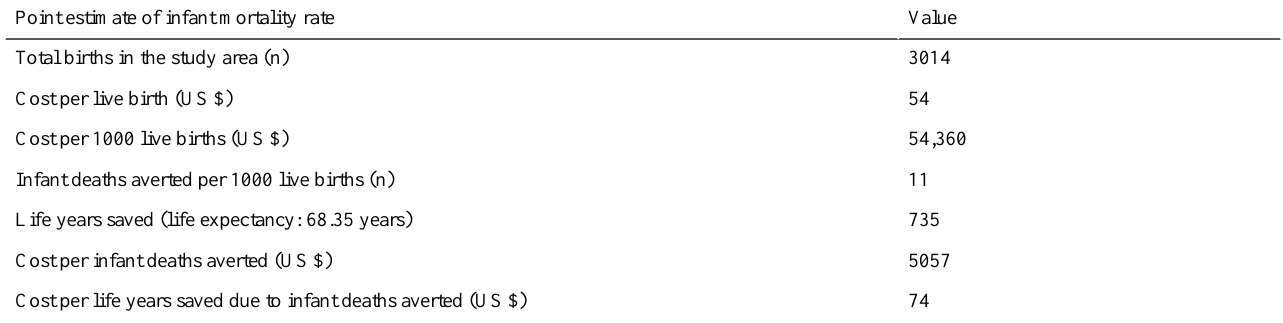
Table 3. Cost-effectiveness of the ImTeCHO a program.